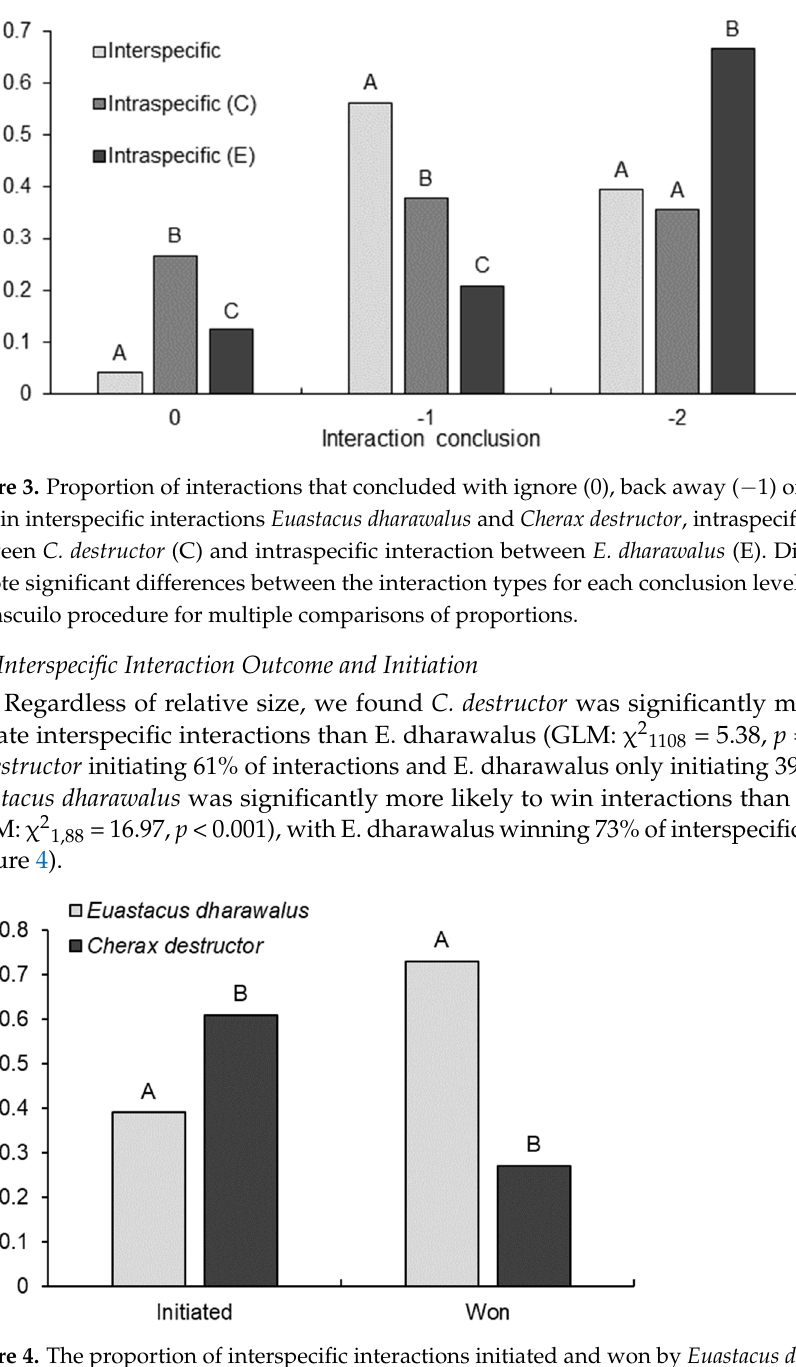
Figure 4. The proportion of interspecific interactions initiated and won by Euastacus dharawalus and Cherax destructor . Different letters denote significant differences based on Tukey’s post hoc tests.